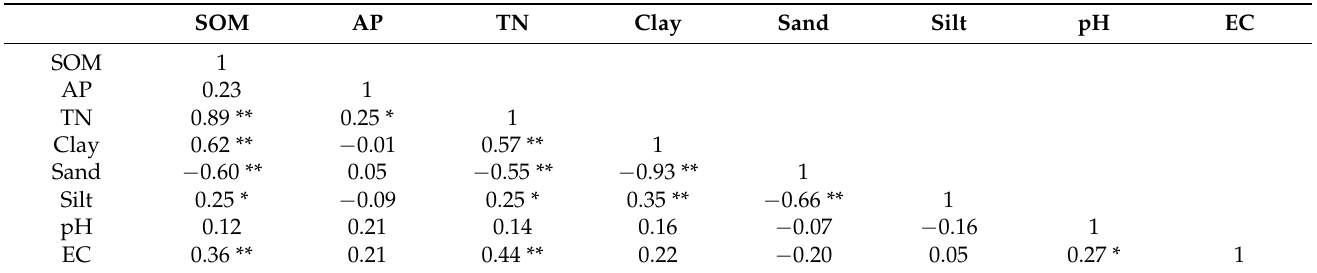
Table 2. Correlation coefficients between